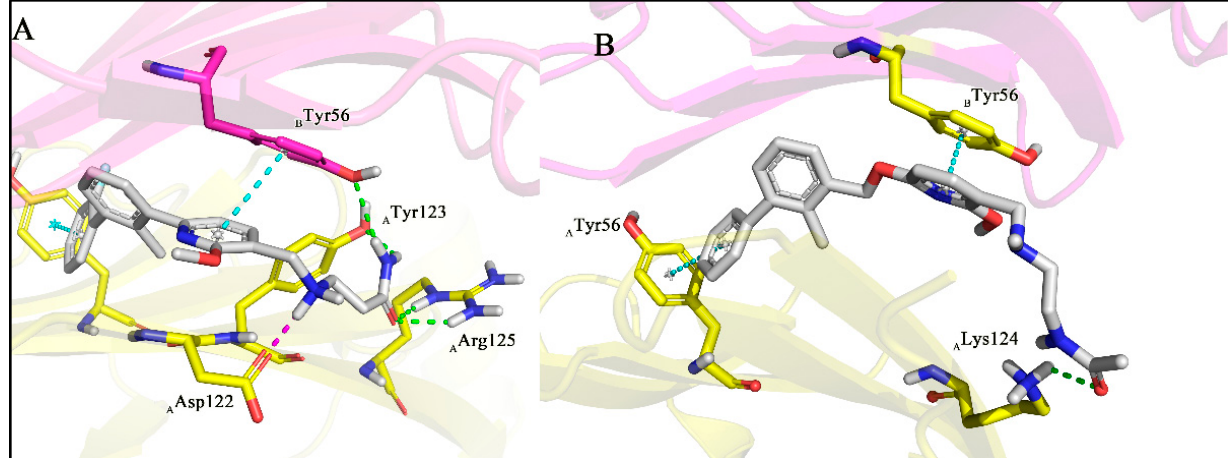
Table 2. Activities of compounds A5 – A18 in inhibition of the PD-1/PD-L1 interaction.